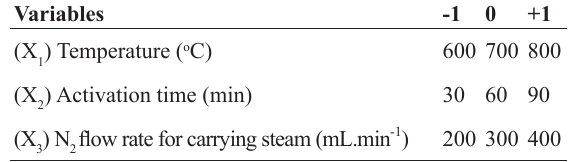
Activated carbon production process parameters.